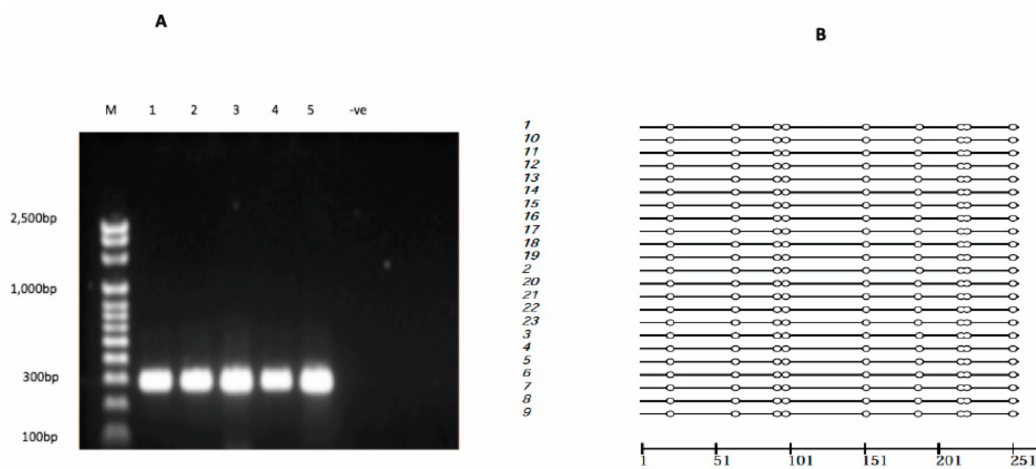
Figure 3. ABCC1 promoter methylation analysis. ( A ) ABCC1 promoter bisulfite PCR products. Clear bands of ~295 bp shown in lanes 1–5 indicate successful bisulfite PCR. − ve represents unmodified human genomic DNA used as a negative control. ( B ) White cycles reported by Methtools represent unmethylated CpG sites [35].